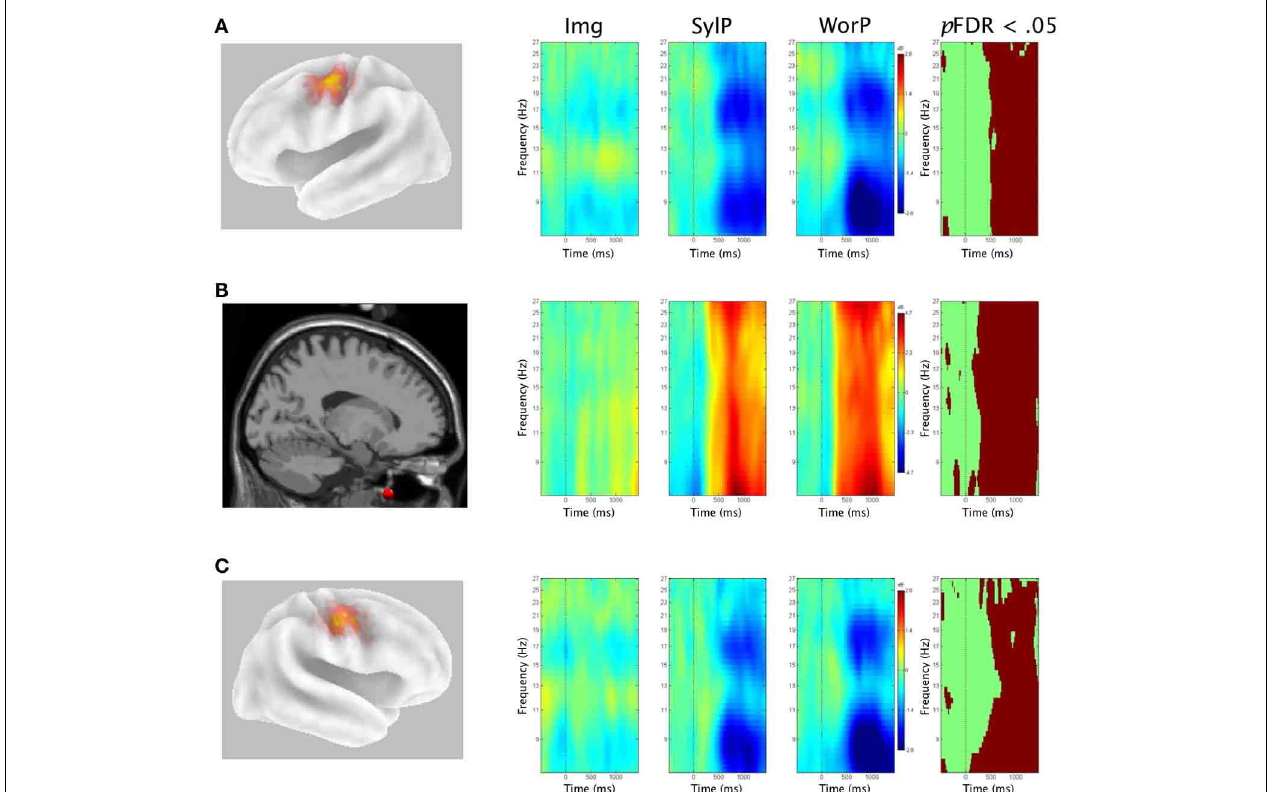
FIGURE 6 | Mean left and right ERSPs and sLORETA solutions for production conditions. Rows A and C show sLORETA solutions for left and right µ clusters, respectively, depicted on a 3D Van Essen average template, followed by mean time-frequency ERSPs (event-related spectral